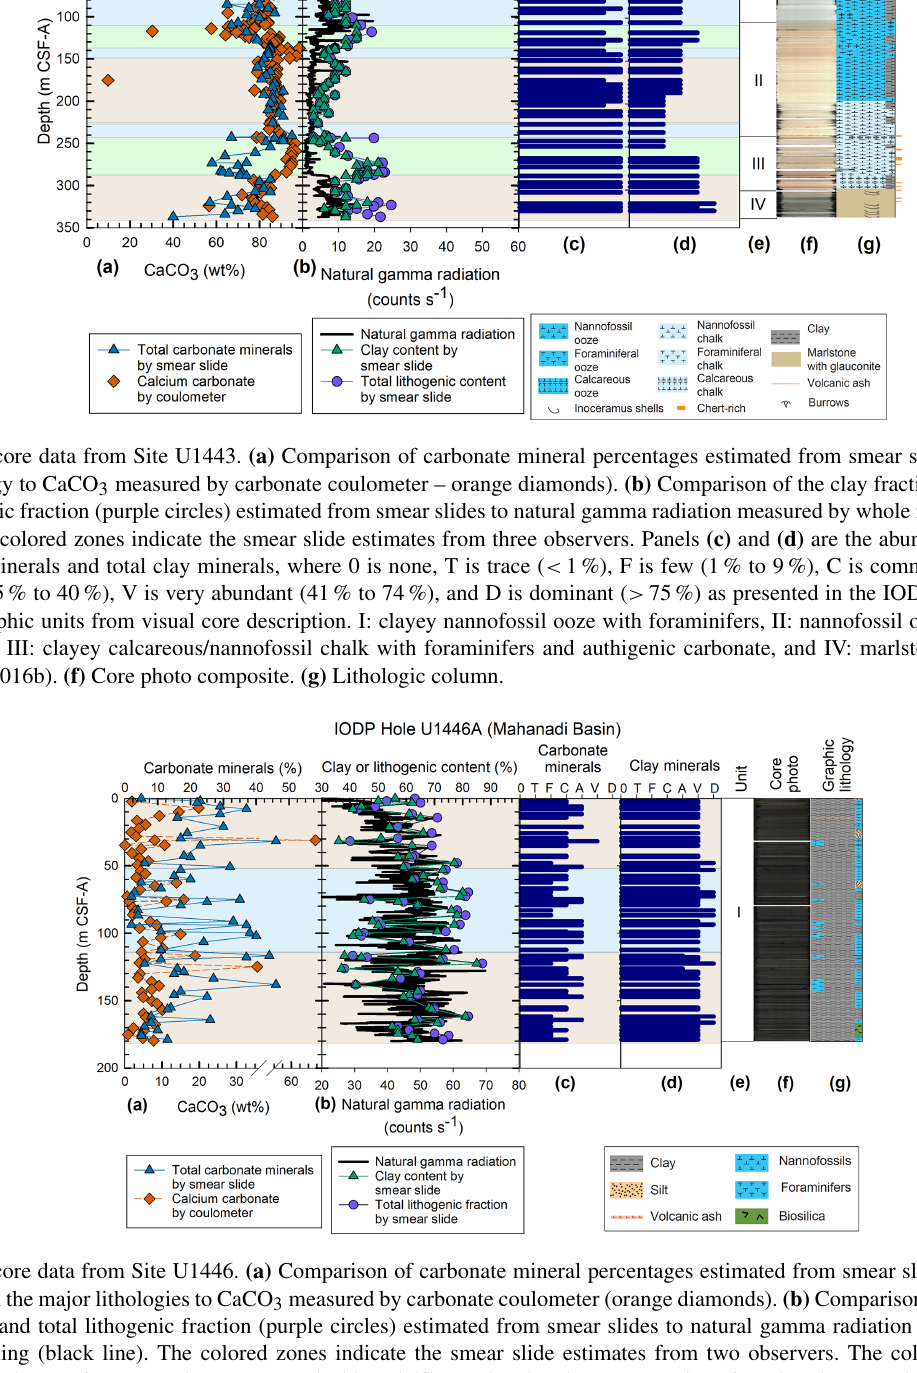
Sci. Dril., 30, 59–74, 2022